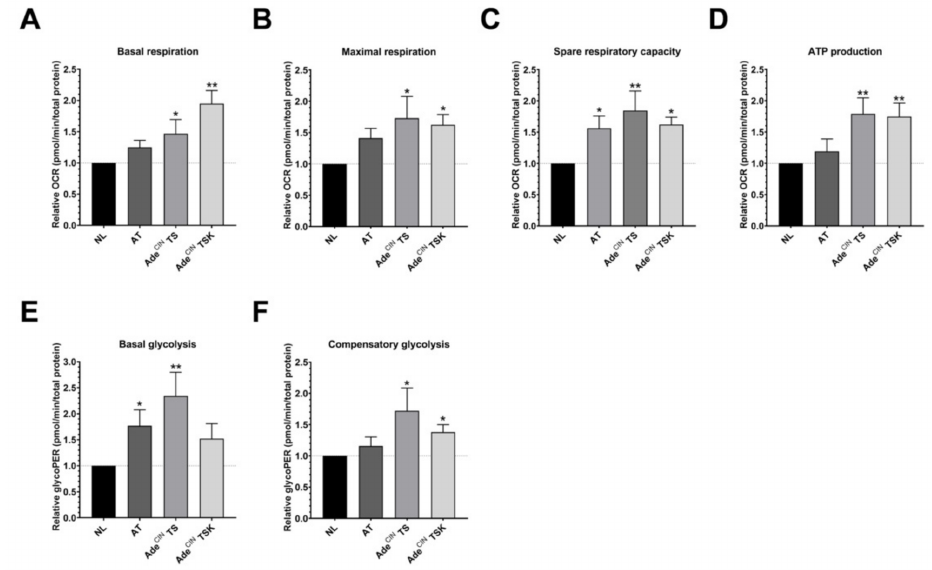
Figure 4. Upregulation of cellular bioenergetics in Ade CIN TS and Ade CIN TSK organoids. Mito- chondrial respiration and glycolysis of NL, AT, Ade CIN TS and Ade CIN TSK organoids after 7 days in culture, assessed by Extracellular Flux Analysis. ( A ) Basal respiration. ( B ) Maximal respiration. ( C ) Spare respiratory capacity. ( D ) ATP production. ( E ) Basal glycolysis. ( F ) Compensatory glycolysis. Data represent mean ± SEM of at least 4 independent experiments. * p < 0.05, ** p < 0.01 compared to